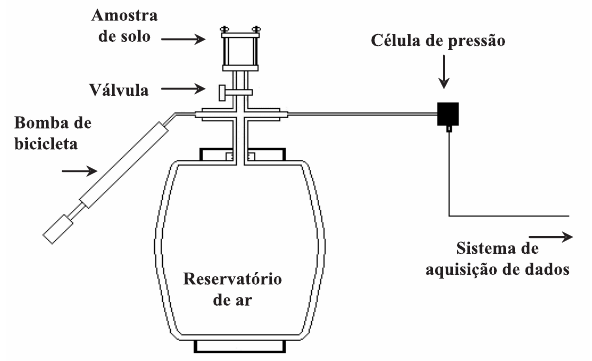
Figura 1. Instrumento utilizado para medir a permeabilidade de amostras indeformadas de solo ao